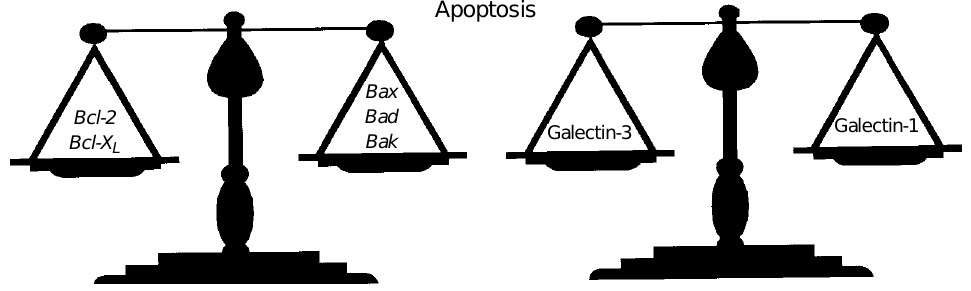
Figure 1 - Galectins-1 and -3: a novel paradigm in the regulation of programmed cell death. Ga- lectins-1 and -3 represent an ad- ditional family of proteins similar to the Bcl-2 family, where different members exhibit se- quence and structure similari- ties, but opposite effects on cell